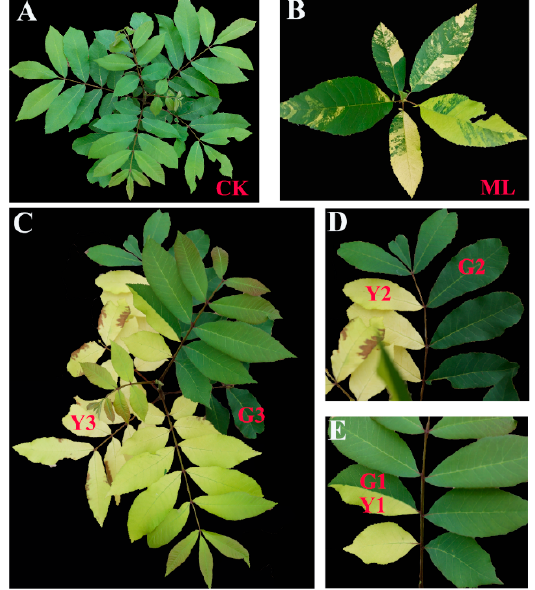
Figure 1. The symptoms of pecan plants infection with PMV. The early developmental stage of annual seedlings bore yellow margins and green interior leaves ( B ). The leaf-variegated plant bore half green leaves and half yellow leaves when developing a pinnately compound leaf ( C – E ). The mosaic leaves (ML, ( B )) were photographed at June 2019. The green leaves (G1, G2, G3) and yellow leaves (Y1, Y2, Y3) of PMV-infected plants and the leaves of healthy plants ( A ) were photographed